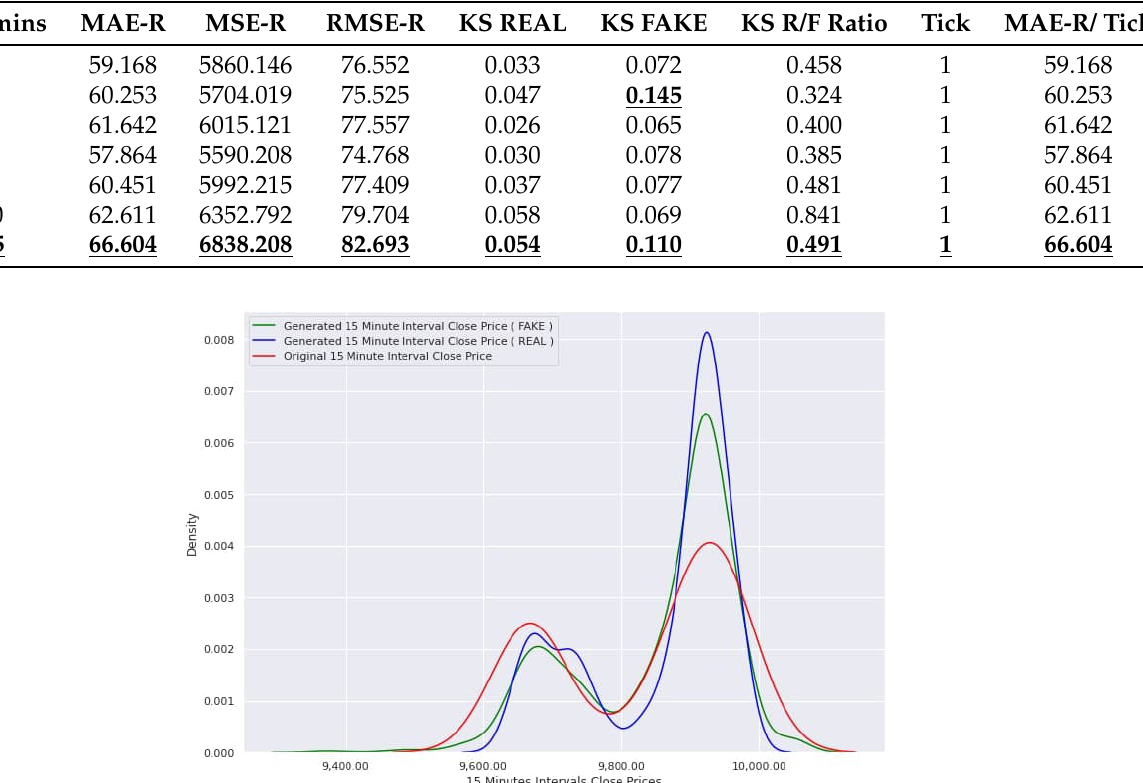
Table 8. GCE-n mins (gold) represent futures contracts (CME) at intervals of one, two, three, four, five, ten, and fifteen. For KS R/F Ratio, all are smaller than one, where the highest KS REAL and FAKE are 0.058 and 0.145.